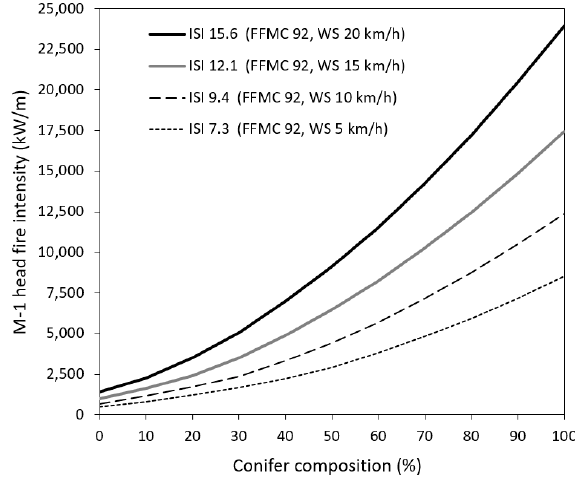
Figure 5. Relationship between conifer fuel composition (%) and head fire intensity (kW/m) in the Canadian Forest Fire Behaviour Prediction (FBP) System M-1 fuel type for four wind speeds (WSs) ranging from 5 to 20 km/h, assuming fine fuel moisture of 9%—Fine Fuel Moisture Code (FFMC) of 92, surface fuel consumption of 1.0–2.5 kg/m 2 given a Buildup Index (BUI) of 60, and 100% foliar moisture content (FMC).